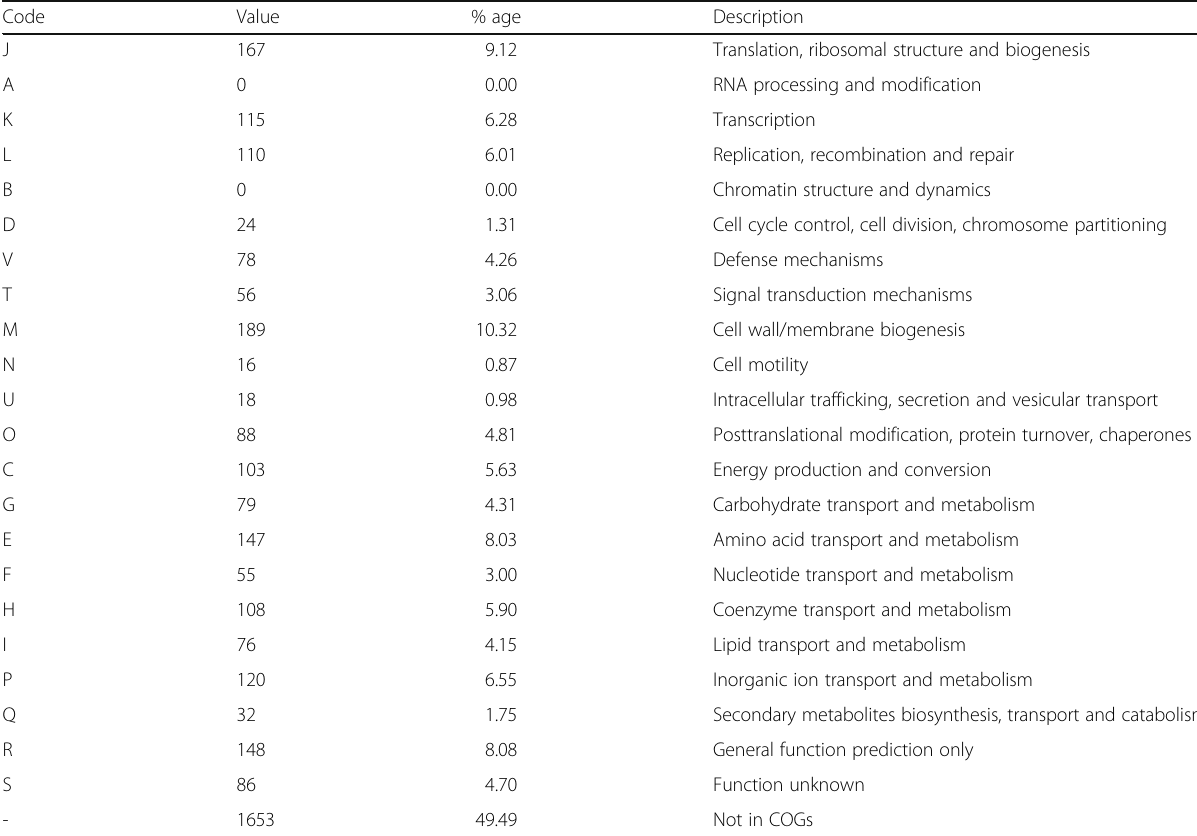
Table 4 Number of genes associated with the general COG functional categories